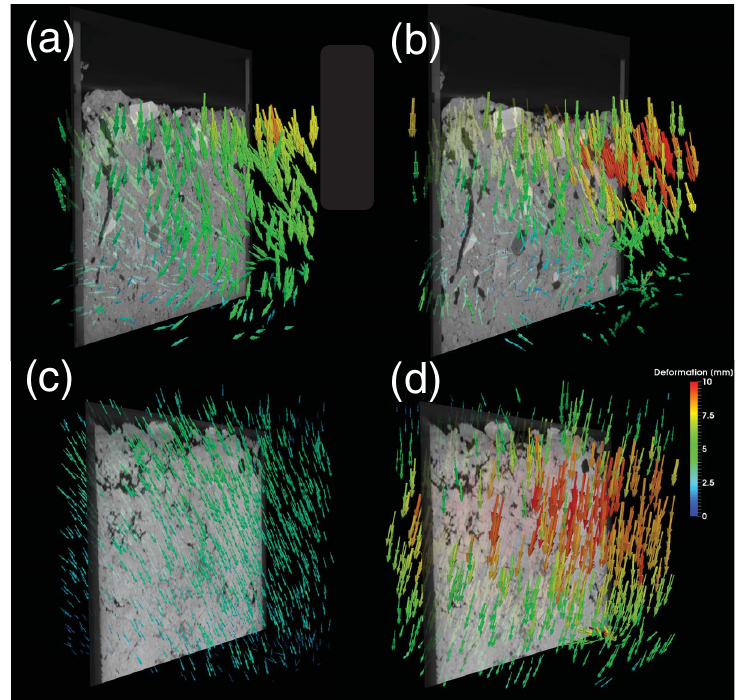
Figure 6. Displacement vector field for the Köllme soil for the deformation (a) from ψ = 0kPa to ψ = − 100kPa and (b) from ψ = 0kPa to ψ = − 500kPa. Only a small percentage of all vectors is displayed to improve visibility. The vector length corresponds to the physical displacement. The two-dimensional section of the undisturbed soil is for orientation. Same is shown for the Bad Lauchstädt soil for the deformation (a) from ψ = 0kPa to ψ = − 50kPa and (b) from ψ = 0kPa to ψ = −